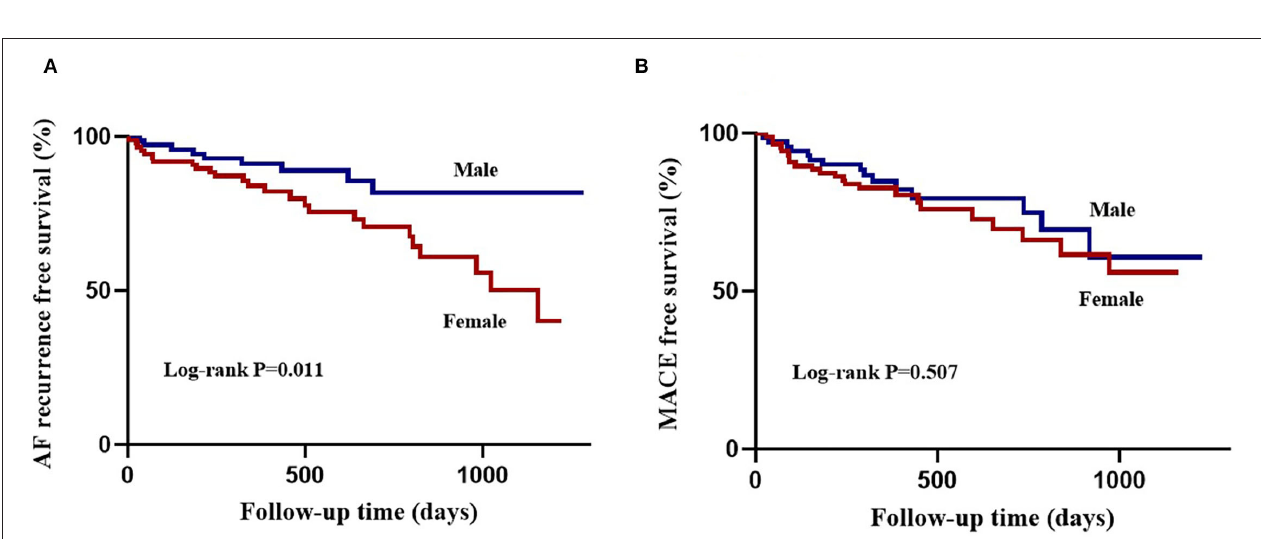
FIGURE 3 | Kaplan-Meier curves of atrial fibrillation outcomes following ablation according to sex. (A) , atrial fibrillation recurrence free survival is lower in females compared with males. (B) , major adverse cardiovascular events free survival is comparable between sexes.